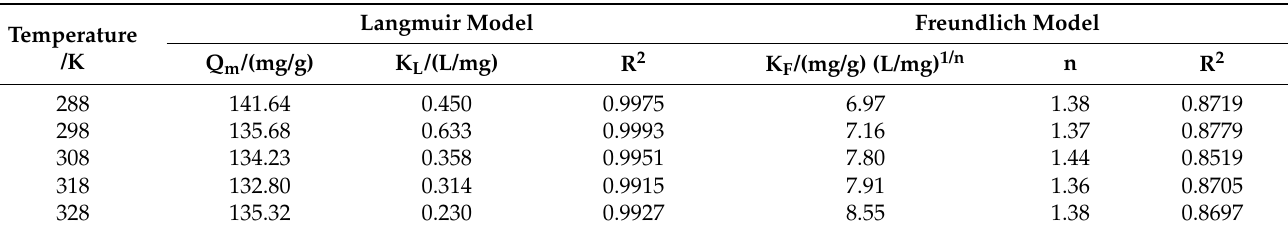
Table 3. Langmuir and Freundlich model fitting parameters.